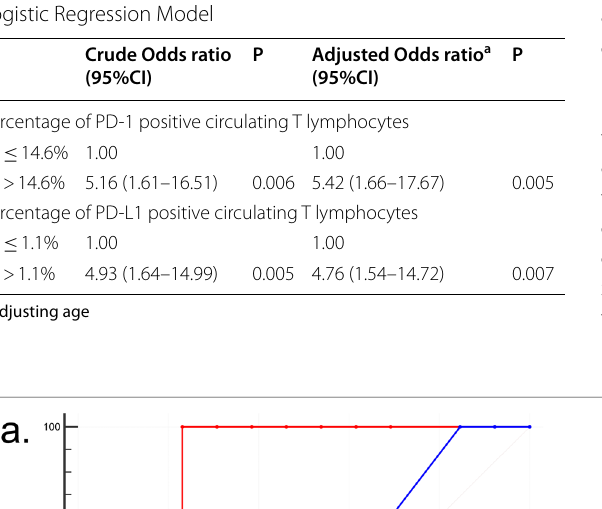
Table 3 The correlation between percentage of PD-1/PD-L1 positive circulating T lymphocytes and TME PD-L1 expression in